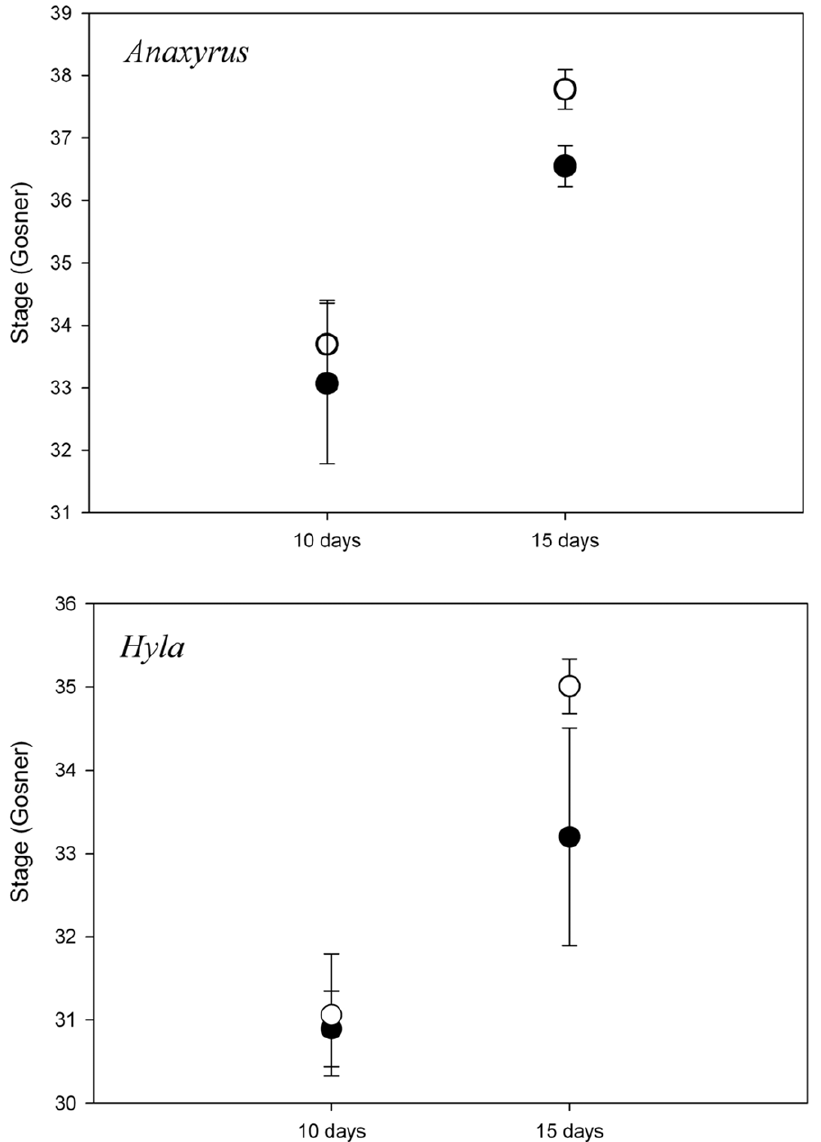
Figure 3. Developmental stage (Gosner) of Anaxyrusfowleri and Hylaversicolor tadpoles raised for 10 and 15 days. Data points represent tank means ( 6 1 SE). Open circles are tadpoles raised in the absence of disease; filled circles are tadpoles raised in the presence of Batrachochytrium dendrobatidis ( Bd ). Overall, tadpoles raised in the presence of Bd were less developed compared to tadpoles raised without Bd (F 1,22 =12.57, p=0.002).